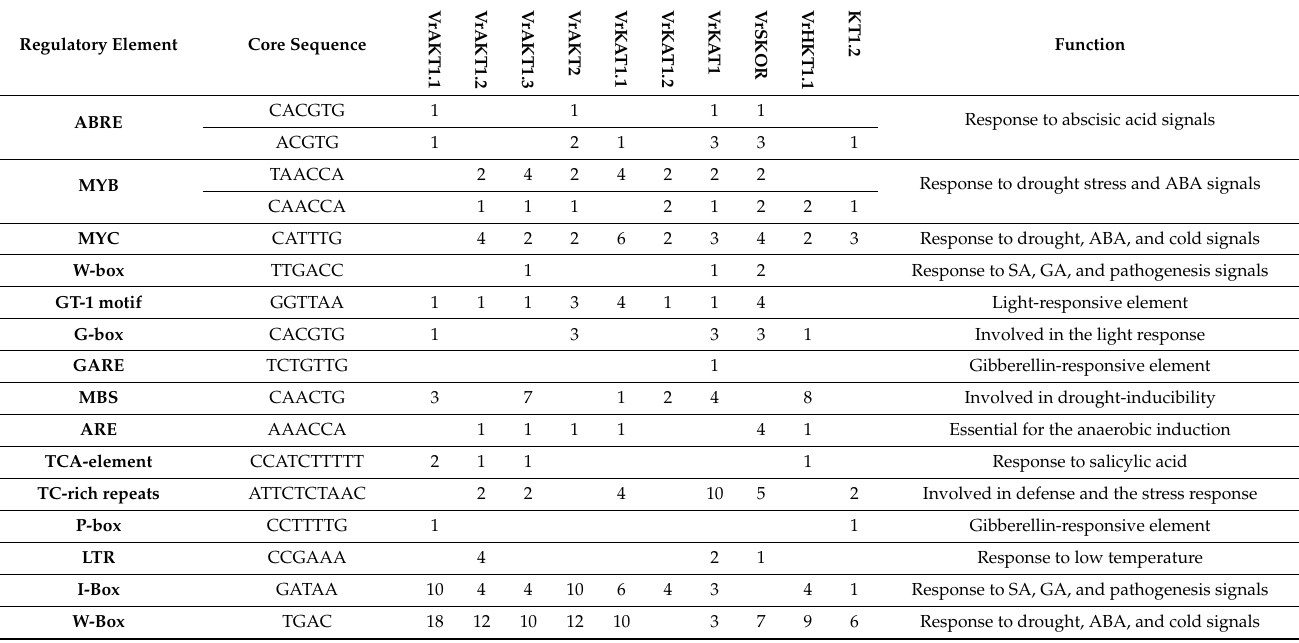
Table 2. Promoter analysis of selected potassium channels and